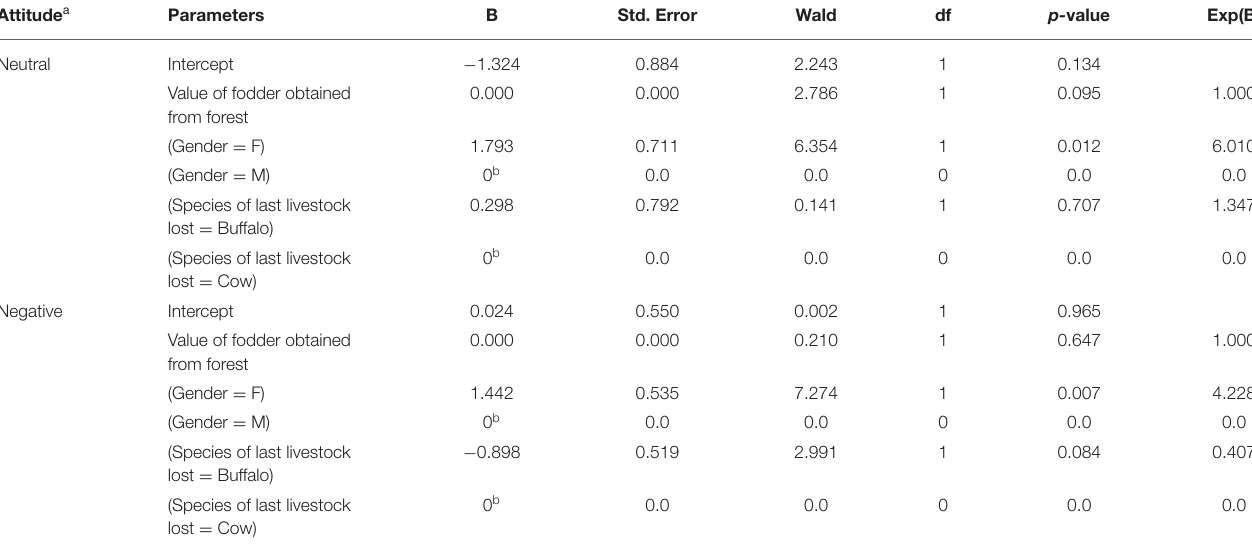
TABLE 6 | Multinomial logistic regression model explaining the attitude of people facing loss towards tiger in Sariska Tiger Reserve: Parameter estimates. Attitude a Parameters Neutral